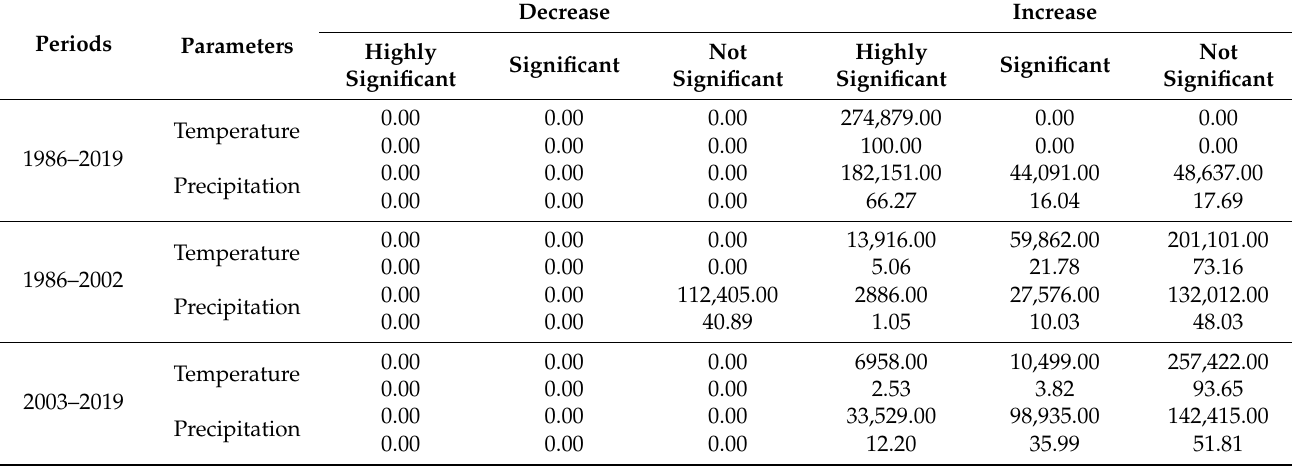
Table 6. Changing trends of the climate factors in Qaidam Basin from 1986 to 2019 (km 2 , %).